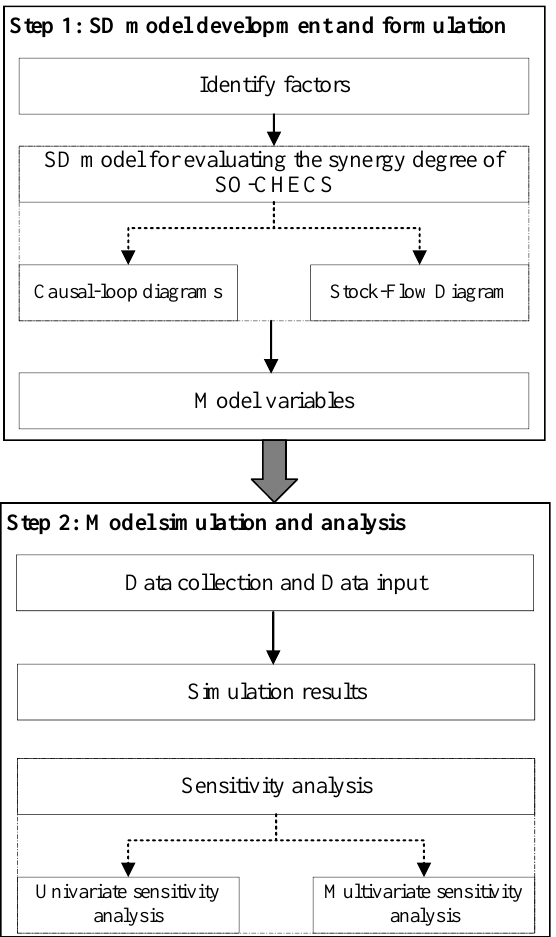
Figure 1. Research framework for research methods and procedures.